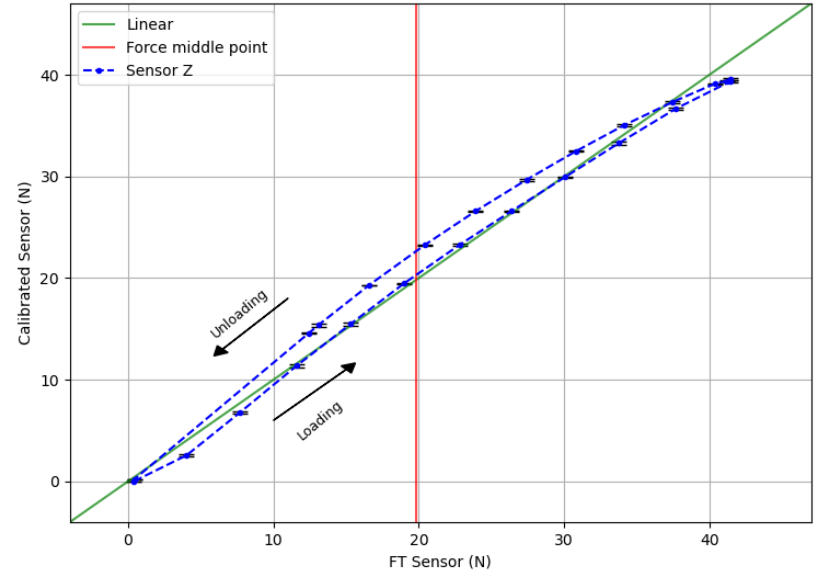
Figure 11. Calibrated sensor response when normal force is applied. The coil was powered with 500